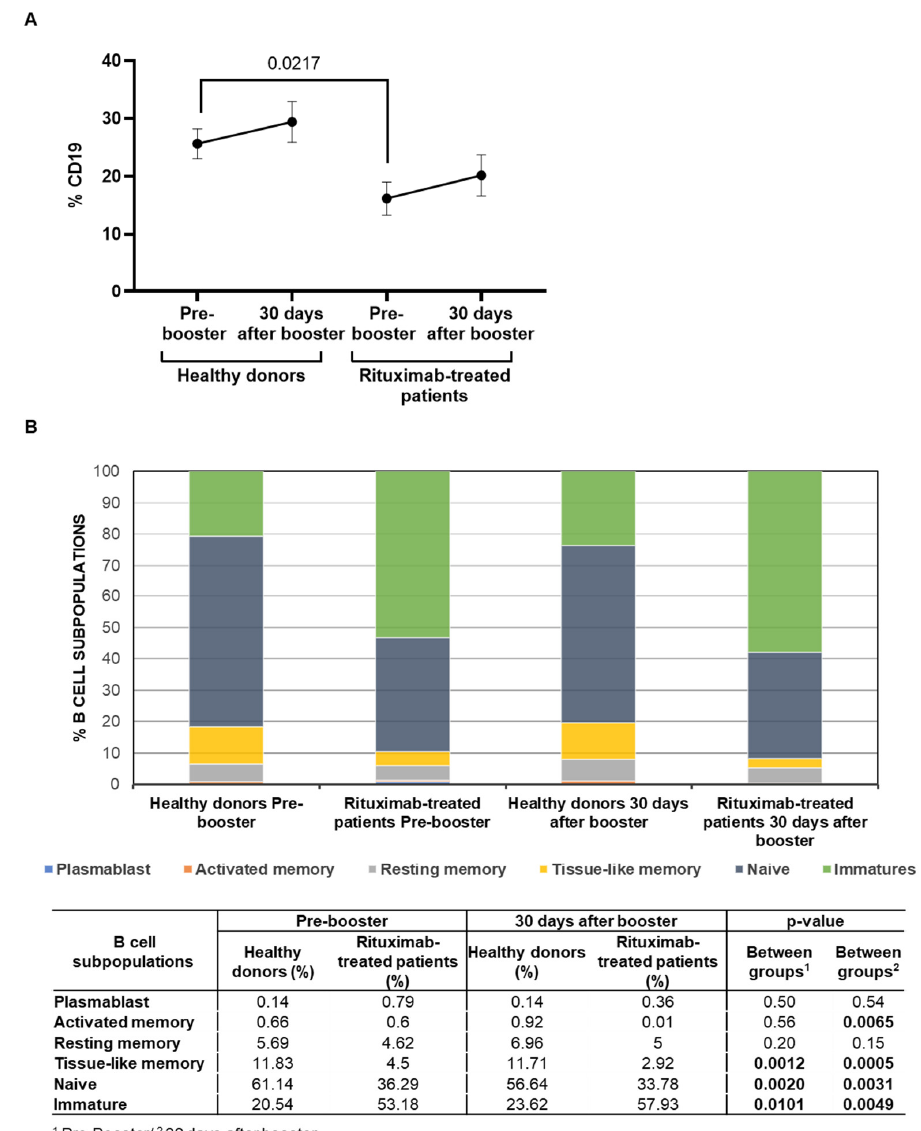
Figure 2. Total levels of B cells and distribution of B-cell subpopulations in PBMCs of rituximab- treated patients and healthy donors before and after receiving the booster dose. ( A ) Total levels of B cells (CD19+) in PBMCs of patients treated with rituximab and healthy donors before and after receiving the booster dose of COVID-19 vaccine. Each dot in the graphs corresponds to the mean ± SEM. Statistical significance was calculated using the Mann–Whitney test. ( B ) Analysis of the distribution of B-cell subpopulations in PBMCs of patients treated with rituximab and healthy donors before and after receiving the booster dose of COVID-19 vaccine. Mean data are represented in bar graphs. Data in the table show the statistical significance between groups that was calculated using Mann-Whitney